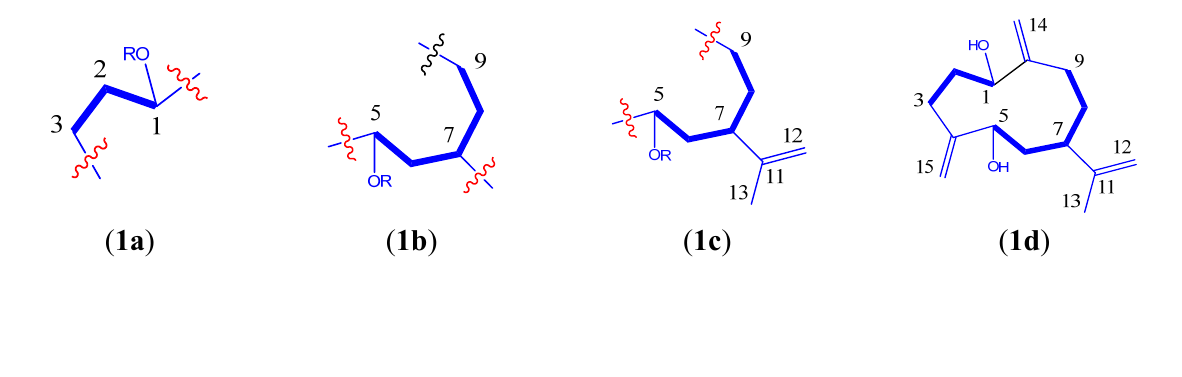
Figure 2. Partial structures of 1